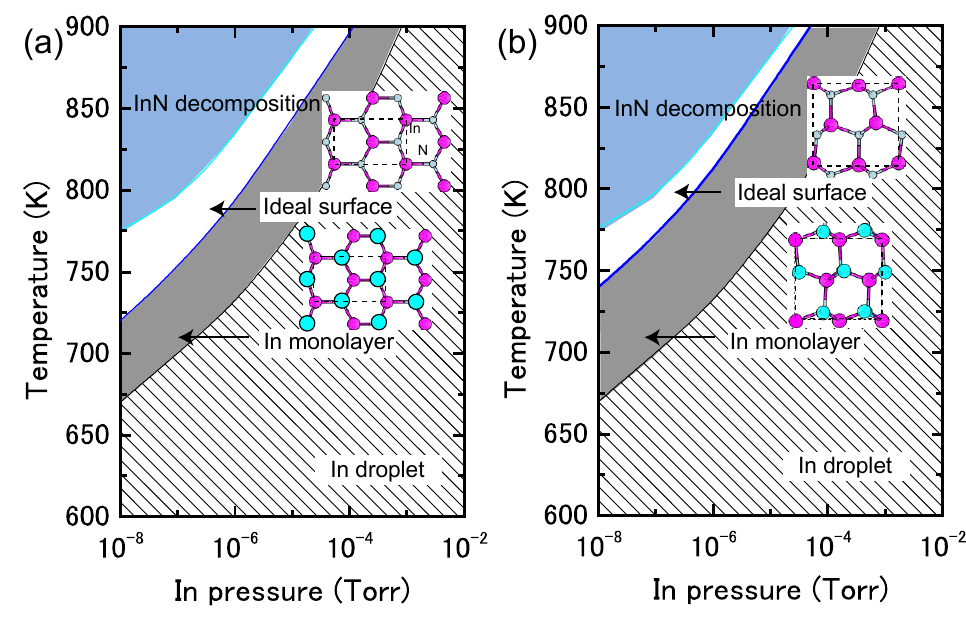
Figure 20. Calculated phase diagrams for nonpolar InN surfaces with ( a ) (cid:4666)11(cid:3364)00(cid:4667) and ( b ) (cid:4666)112(cid:3364)0(cid:4667) orientations as a function of temperature and In BEP. The stable reconstructions on these surfaces are also schematically